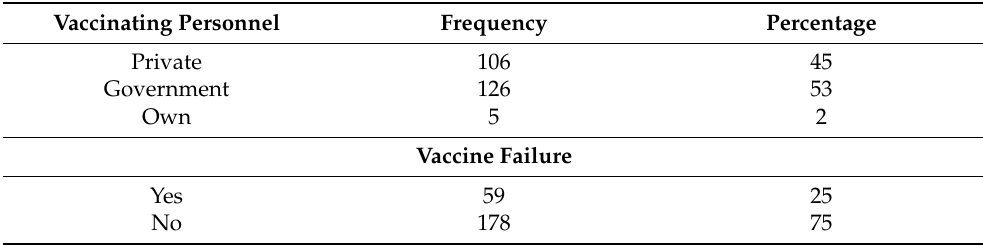
Table 2. FMD vaccine failure (recurrent outbreak after vaccination) and vaccinating personnel’s frequency from 2018 to 2020 ( N = 237).